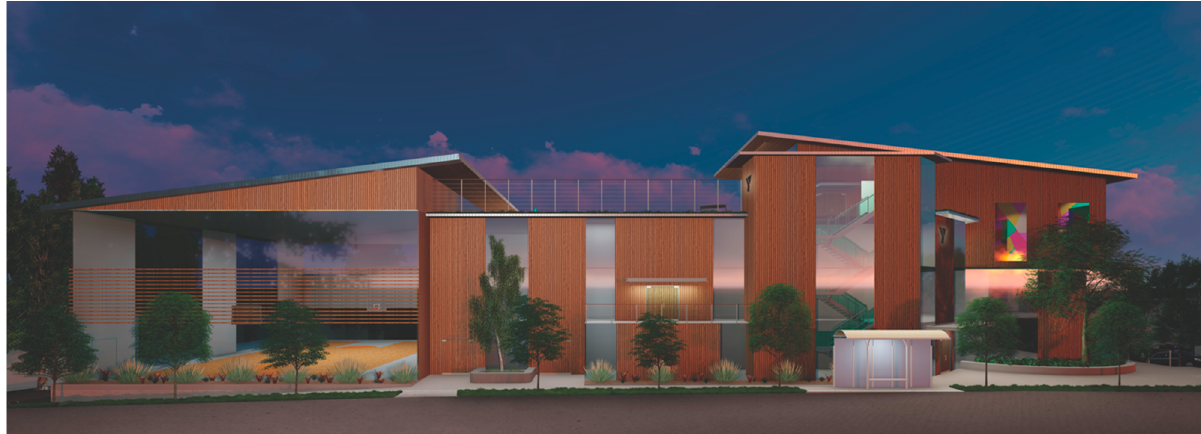
Figure 5. Rendering of a shared Ebenezer AME Zion Church-Meredith Mathews East Madison Y building. Source: Ebenezer-YMCA Team (Building Beloved Community, p. 64).